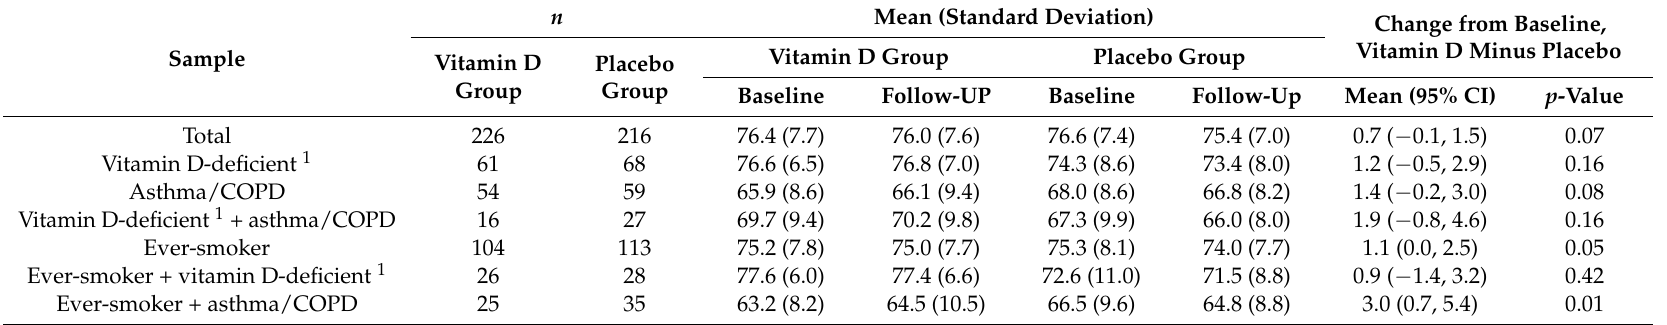
Table 4. FEV1/FVC (%) at baseline and follow-up (adjusted for age, sex, ethnicity and height) by treatment group.